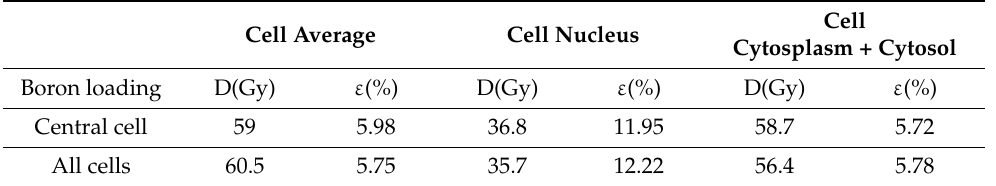
Table 6. GEANT4 simulation dose results of the microdosimetric model with respective relative uncertainty ( ε ) for 4 × 10 12 n th .cm − 2 (thermal